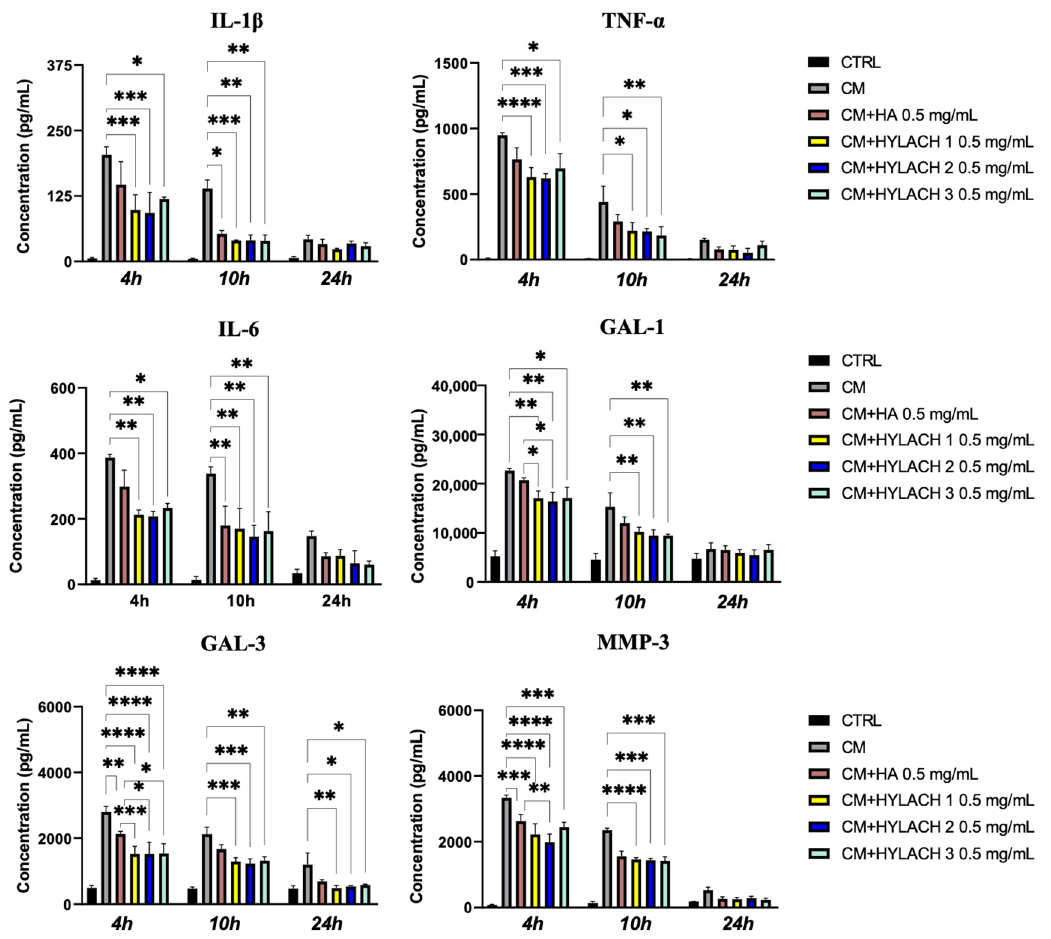
Figure 6. IL-1 β , TNF- α , IL-6, Gal-1, Gal-3, and MMP-3 protein expression in primary bronchial fibroblasts after exposure to U937 CM in the presence or absence of HYLACH. Primary human smokers’ bronchial fibroblasts were cultivated in the presence or absence of 0.5 mg/mL HA and HYLACH after 24 h of exposure to activated U937 CM. At 4, 10, and 24 h following treatment, ELISA was used to analyze IL-1 β , TNF- α , IL-6, Gal-1, Gal-3, and MMP-3 protein expressions. The one-way ANOVA test with multiple comparisons was used to determine statistical differences. The results are presented as mean ± SE of three independent experiments. CM stands for fibroblast cultures that have been exposed to U937 CM. * p < 0.05, ** p < 0.01, *** p < 0.001, and **** p < 0.0001 vs. respective CM-treated control. Percentage of lactose-derived residues: HYLACH 1 = 10%, HYLACH 2 = 30%, and HYLACH 3 = 40%.